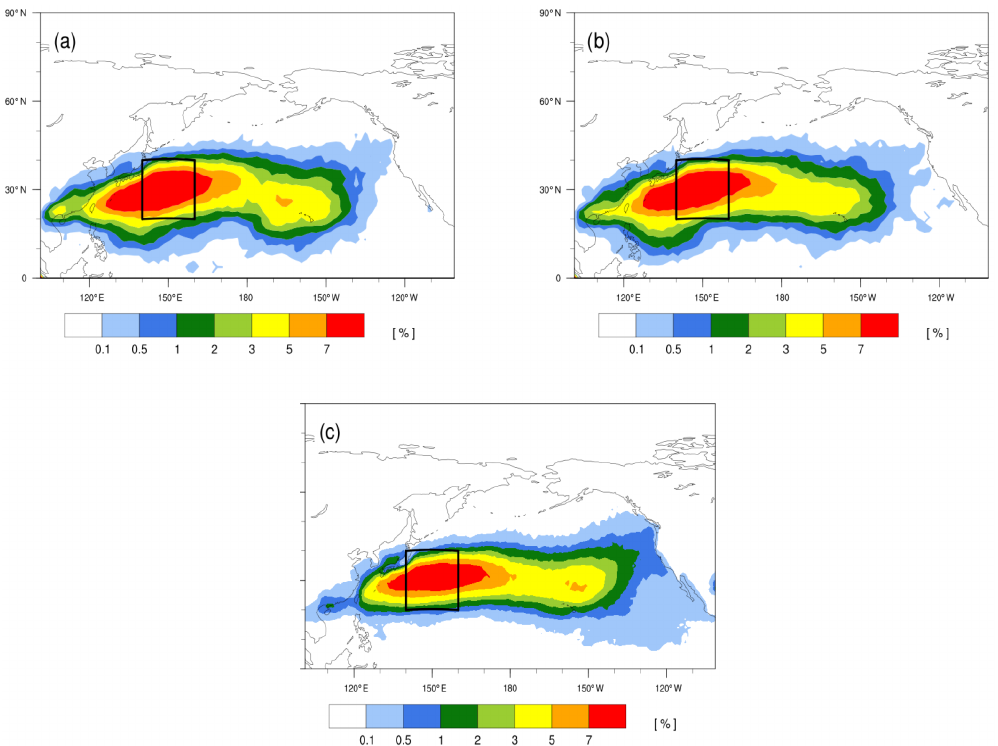
Figure 1. Climatological frequency of WCB starting points in winter (DJF) for PI (a) , PD (b) and ERA-Interim (c) . Colours represent the relative frequency (in %) of WCB trajectories at each grid point. The black box denotes the starting region of the WCBs considered in the analysis